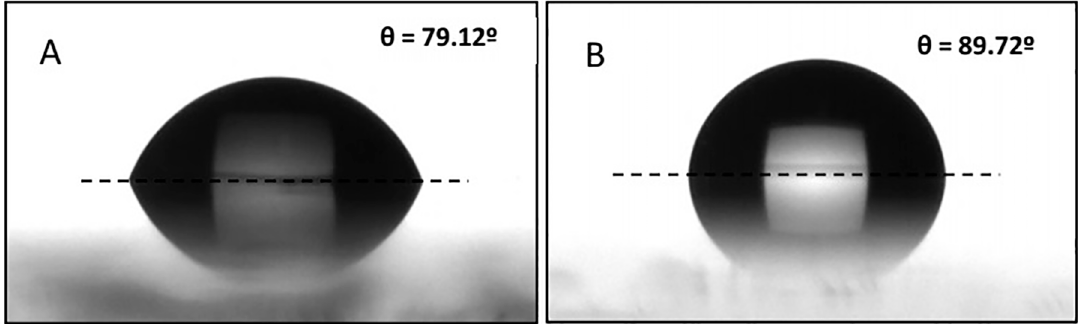
Figure 6. Images of drop profile obtained in the wettability test for the samples with withdrawal speed of 2 cm/min, without heat treatment (A) and the sample with withdrawal speed of 4 cm/min, with heat treatment (B)